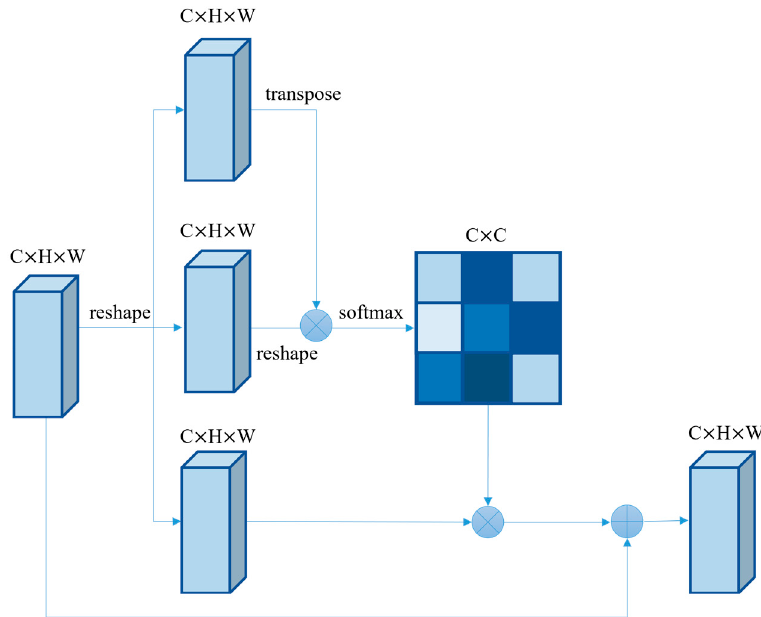
Figure 4. Architecture of Channel Attention Module [18].